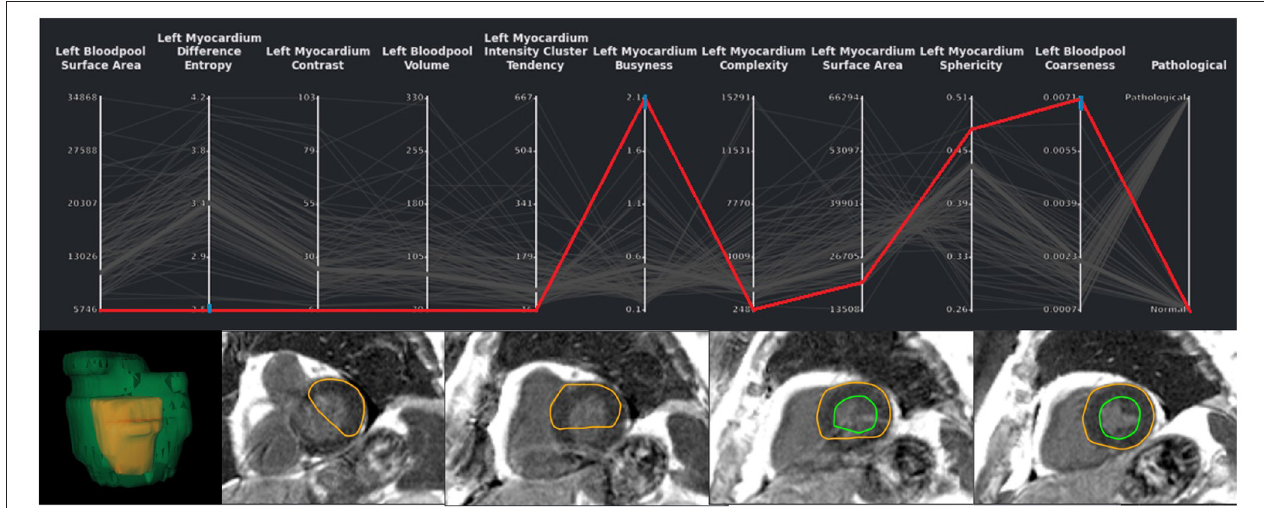
FIGURE 4 | Exemplary case of a segmentation outlier (represented by the red line) in the total EMIDEC study consisting of 100 cases. It can be identified in the PCP by three blue brushes. In the image viewer the erroneous segmentation is clearly visible.